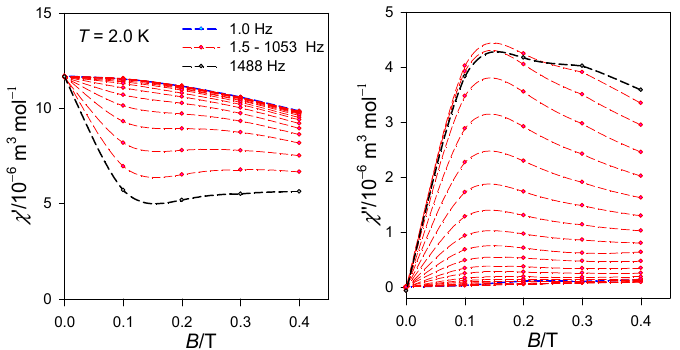
Figure 4. Field dependence of the AC susceptibility for 1 for a set of frequencies at T = 2.0 K.